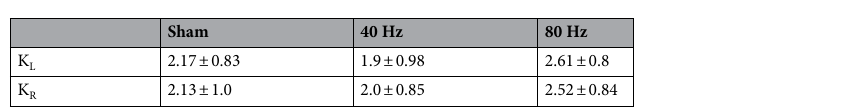
Table 2. The mean and standard deviation of K L and K R values under each stimulation